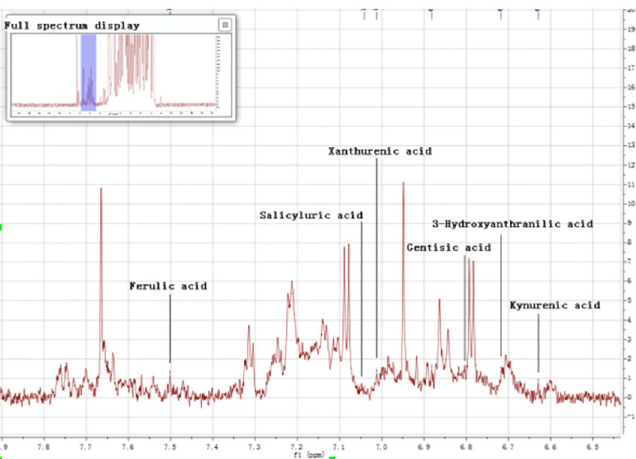
Fig 7. The peaks of six principal components on the